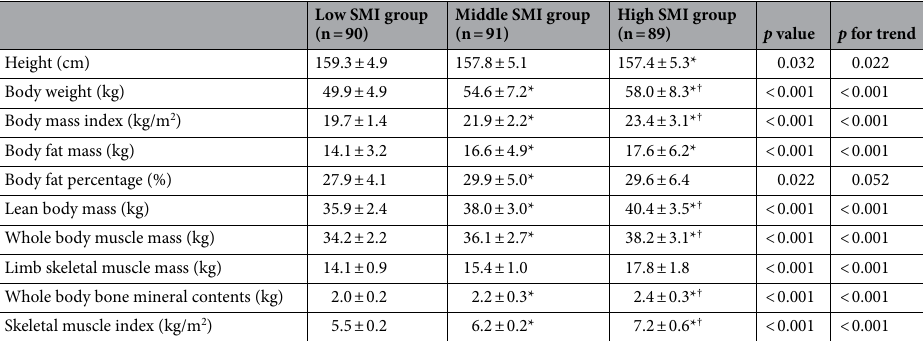
Table 2. Comparison of anthropometry and body composition among three groups. Data are mean ± standard deviation. Jonckheere–Terpstra test was used for trend analysis. Analysis of variance was used for comparison among three groups. Bonferroni method was used for post-hoc analysis. SMI: skeletal muscle mass index. *Significantly different from low SMI group ( p < 0.05). † Significantly different from middle SMI group ( p < 0.05).